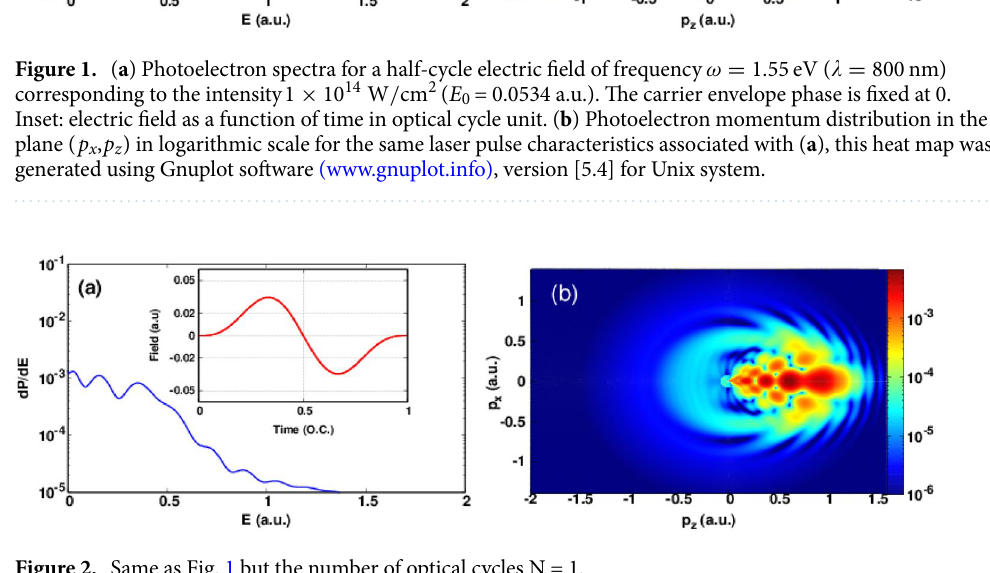
Figure 2. Same as Fig. 1 but the number of optical cycles N =